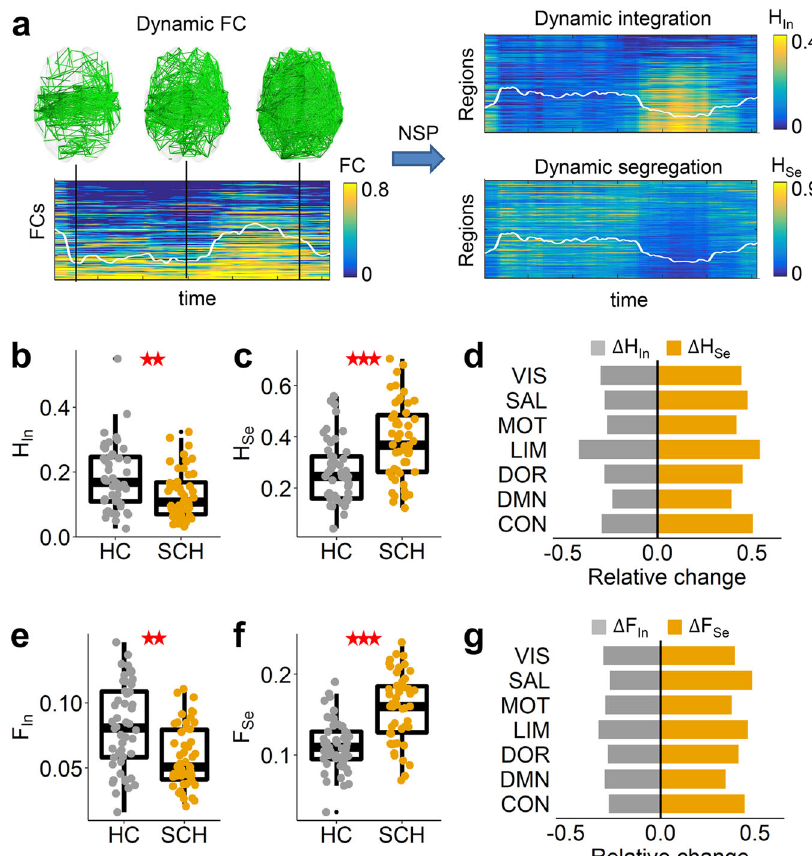
Fig. 1 Dynamic segregation and integration. a Schematic diagram of dynamic segregation and integration analysis. The brain functional connectivity (FC) network temporally switches between segregated (low FC) and integrated (high FC) state. Using the NSP method, this dynamic transition can be studied separately in two dimensions: dynamic segregation and integration. The white lines indicate the mean values, and the ranges of the y-axis are indicated by the color bars. b Comparisons of integration strength H In and c segregation strength H Se between the healthy control (HC, n = 50) and schizophrenia (SCH, n = 50) groups. Each point indicates the value of an individual, and the boxplot of each group was also provided. ** indicates a signi fi cant group difference with p < 0.01, *** p < 0.001. d Relative changes in integration strength H In and segregation strength H Se from HC to SCH in seven functional systems. All systems had signi fi cant alterations ( p < 0.05, FDR corrected). e Comparisons of integration variability F In , f segregation variability F Se between HC and SCH groups. g Relative changes in the integration variability F In and segregation variability F Se from HC to SCH in seven functional systems. All systems had signi fi cant alterations ( p < 0.05, FDR corrected). VIS: visual, MOT: motor, DOR: dorsal attention, SAL: salient attention, LIM: limbic, CON: control, DMN: default-mode network (see similar results for the brain parcellation of 500 regions in Supplementary Fig.